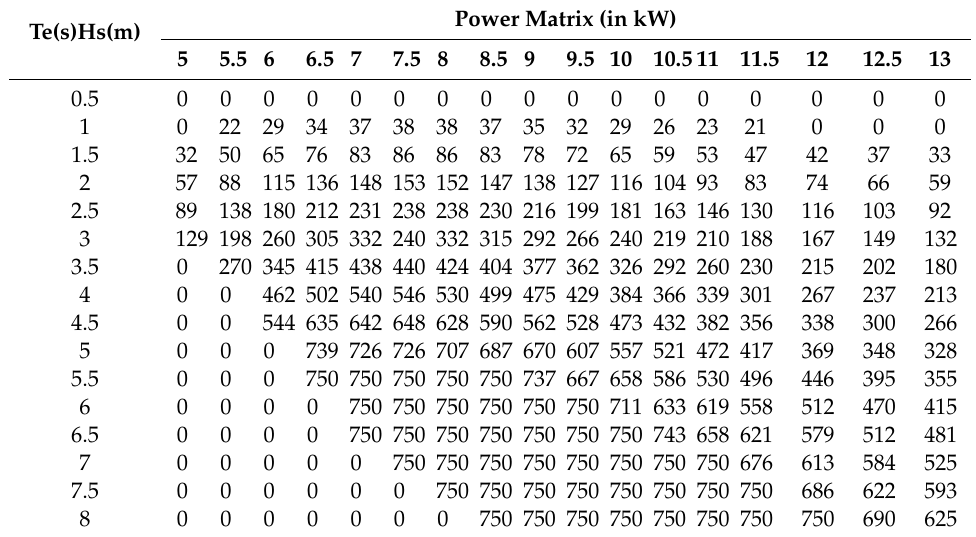
Table 3. Pelamis power matrix (in kW)